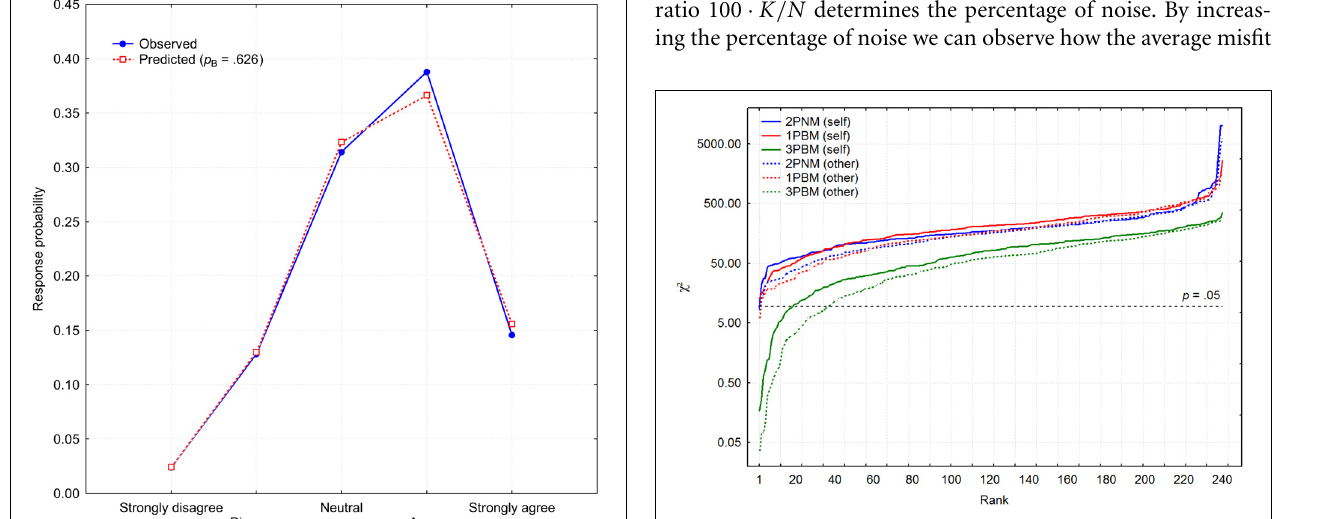
FIGURE 2 | Observed (blue) and predicted (red) response probabilities for the other-rated item i 239 (A6: Tender-Mindedness).